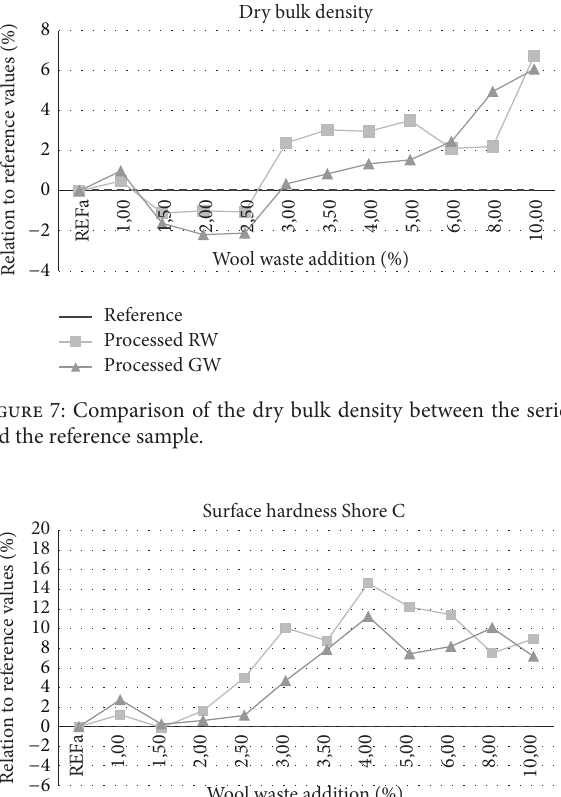
Figure 6: Recycled and treated rock wool seen under the micro- scope with five enlargements.